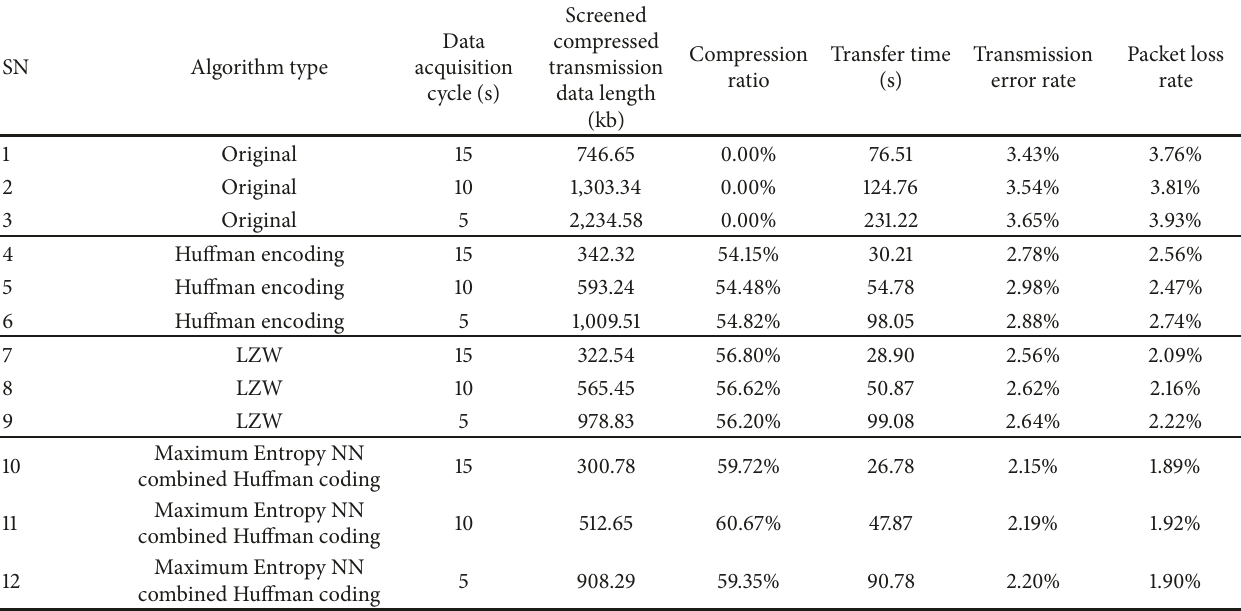
Table 3: Screening data compression test